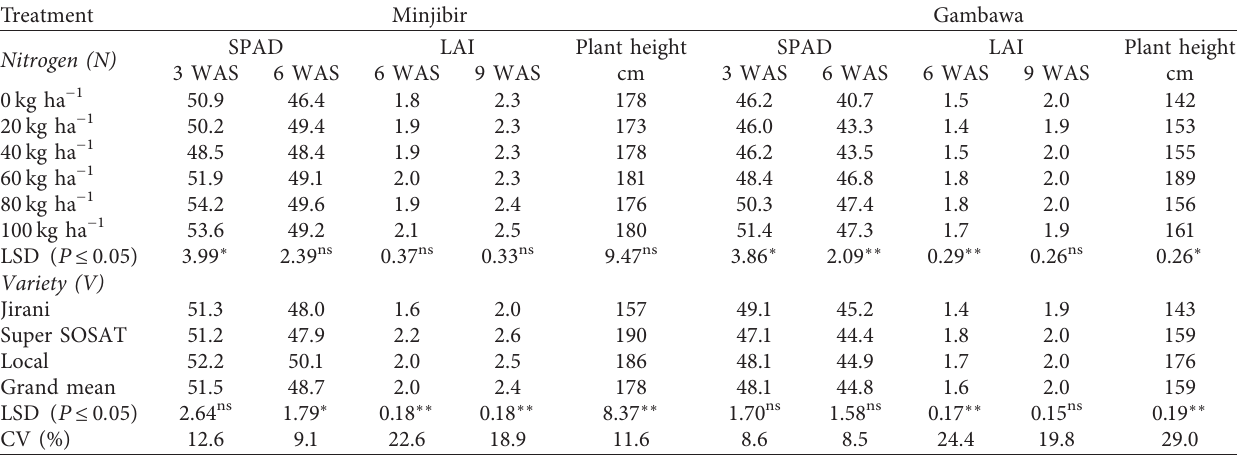
Table 2: Effect of N-fertilizer rates and pearl millet variety on soil plant analysis development (SPAD), leaf area index (LAI), and plant height over two growing seasons in the semiarid zone of